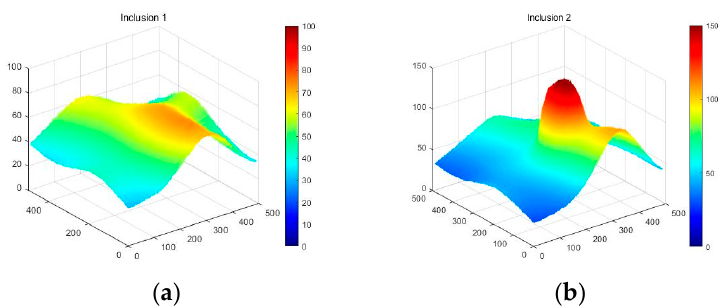
Sensors 2023 , 23 , x FOR PEER REVIEW Figure 31. Three-dimensional elasticity-image simulation by size: ( a ) 8 mm, ( b ) 12 mm.